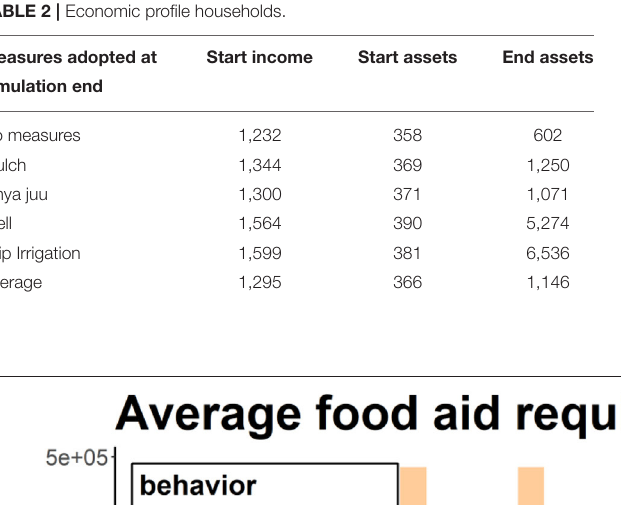
Frontiers in Water |